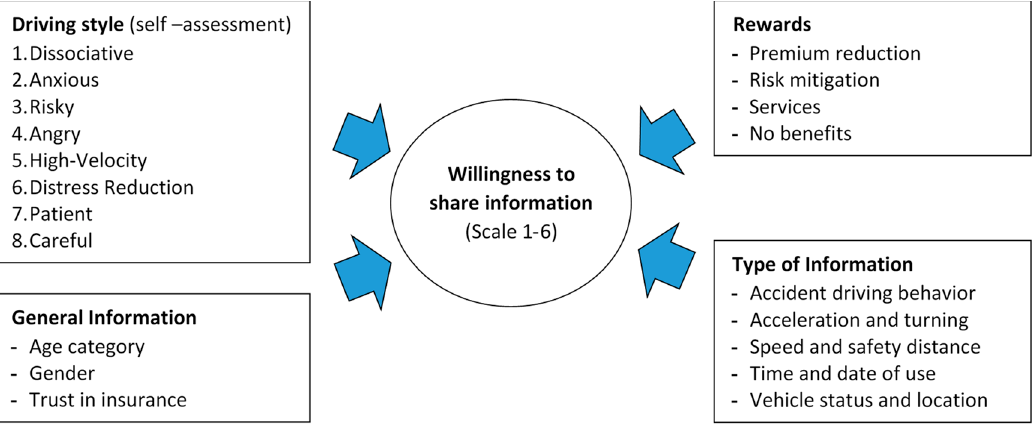
Figure 1. Questionnaire structure.